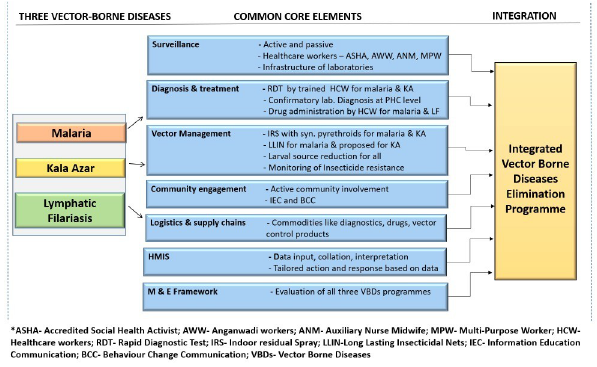
Fig 2. Integration of 3 vector-borne disease control